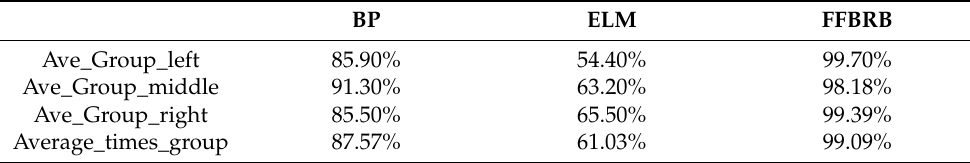
Table 7. Comparison of results of different methods.